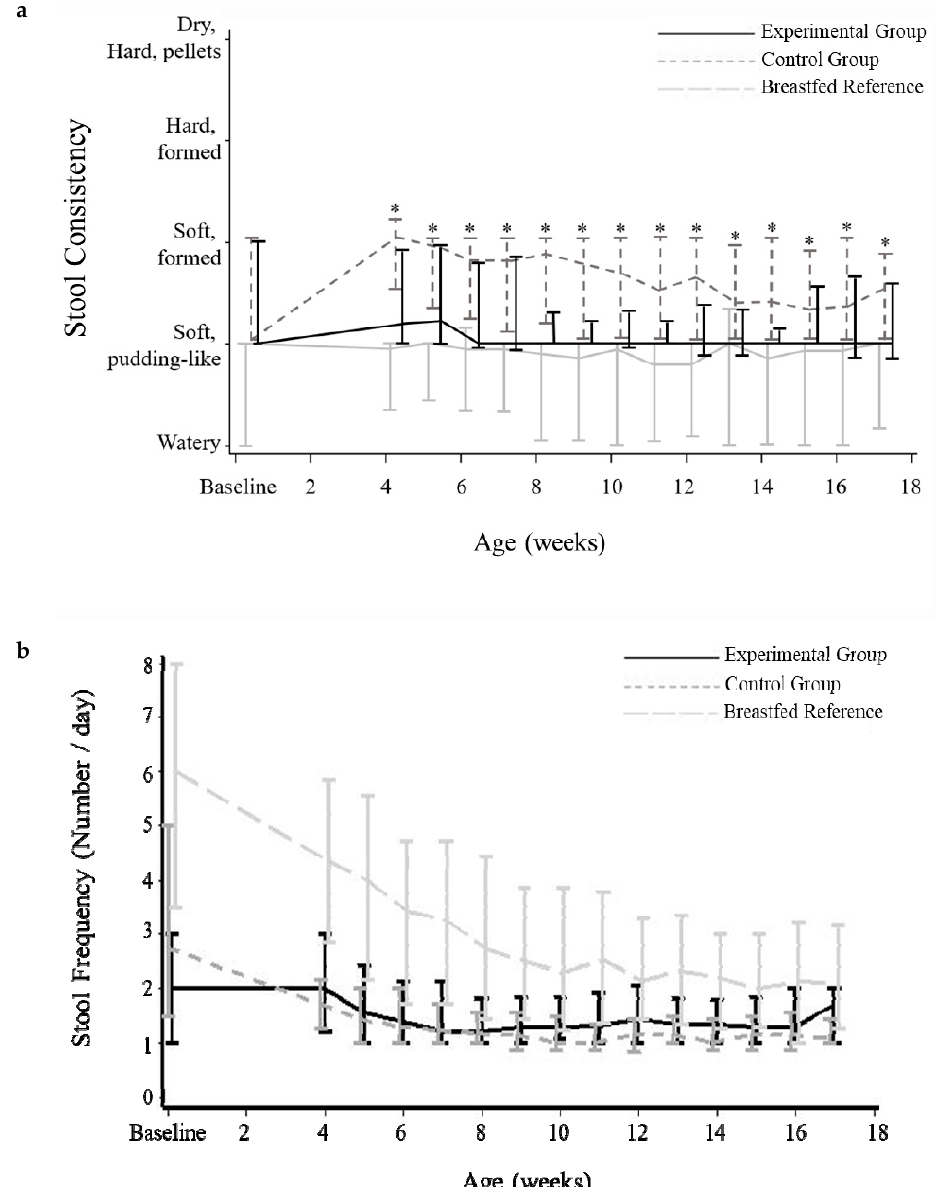
Figure 3. Median stool consistency ( a ) and stool frequency ( b ) for each study group over time in the PP t population. Median (lines) and Q1–Q3 (bars) value are shown per week. Data for baseline were collected as a value per subject as indicated by the parents at the baseline visit. Subsequent values are the mean of each week as reported by parents in the daily diaries. * Statistical difference vs. Experimental Group ( p < 0.05; Wilcoxon-Mann-Whitney test). PP t = Per protocol population for diary data on tolerance outcomes.